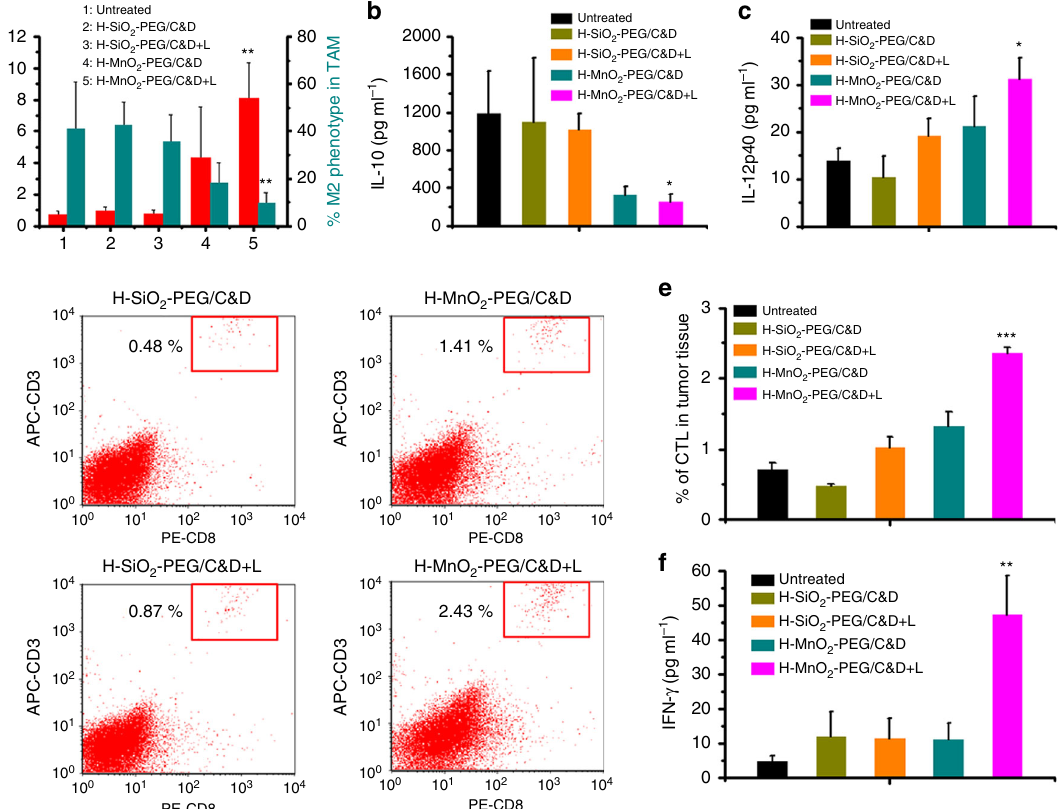
Fig. 6 Immunological responses after combined chemo-PDT with H-MnO 2 -PEG/C&D. a Macrophages in fi ltration and polarization within tumors post various treatments. CD11b + CD206 + cells were de fi ned as M2 phenotype macrophages (six mice per group). The total number of macrophages in fi ltrated in tumors markedly increased post the combined chemo-PDT, which also resulted in polarization of M2 phenotype TAM towards M1 TAM. b , c The levels of IL-10 ( b ) and IL-12p40 ( c ) in the supernatant of tumors post various treatments. d , e Representative fl ow cytometry data of cytotoxic T lymphocytes (CTL) in fi ltration in tumors. CD3 + CD8 + cells were de fi ned as CTLs. f The production of IFN- γ in sera of mice post various treatments. p values were calculated by Tukey ’ s post-test between group 5 (H-MnO 2 -PEG/C&D+ L) and group 1 (untreated) (*** p < 0.001, ** p < 0.01, or * p < 0.05) (compared with untreated). Date are presented as means ± s.d. ( n =